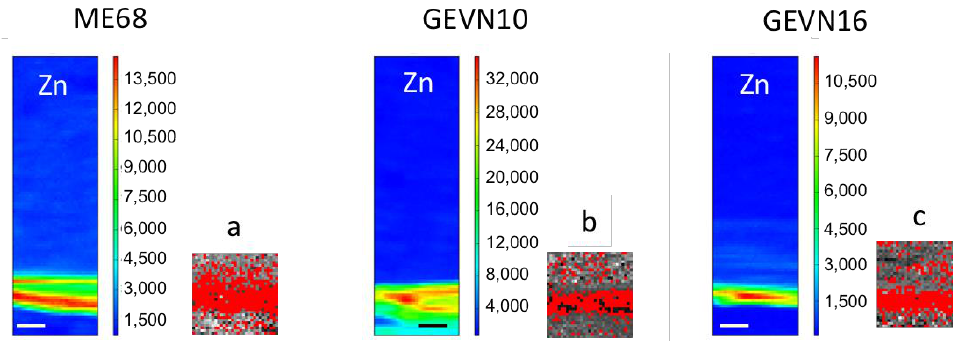
Figure 5. Zn XRF maps of sample ME68, GEVN10 and GEVN16 in cross section geometry, together with the corresponding distribution of ZnAl 2 O 4 phase, depicted in red in panels ( a – c ). Scale bar is 50 µm.